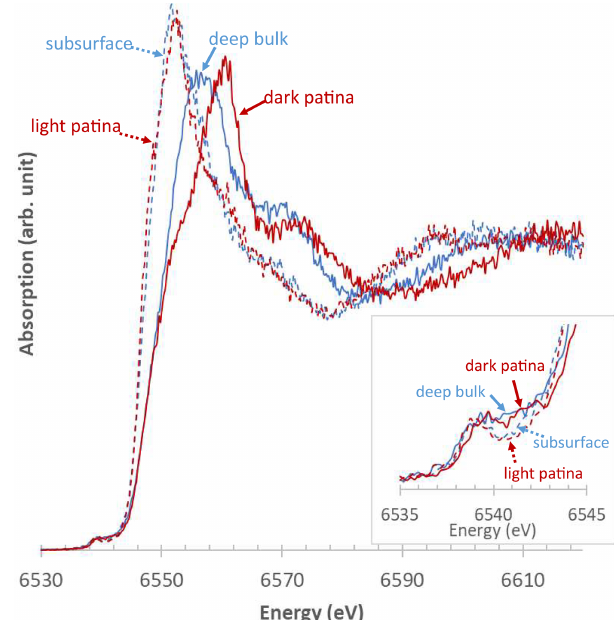
Figure 10. Representative XANES spectra obtained at the Mn K- edge from Mn-rich zones of L2. Solid blue line: deep bulk; dashed blue line: subsurface; dashed red line: lightly colored patina; solid red line: dark patina. Inset: zoom-in on the pre-edge region.